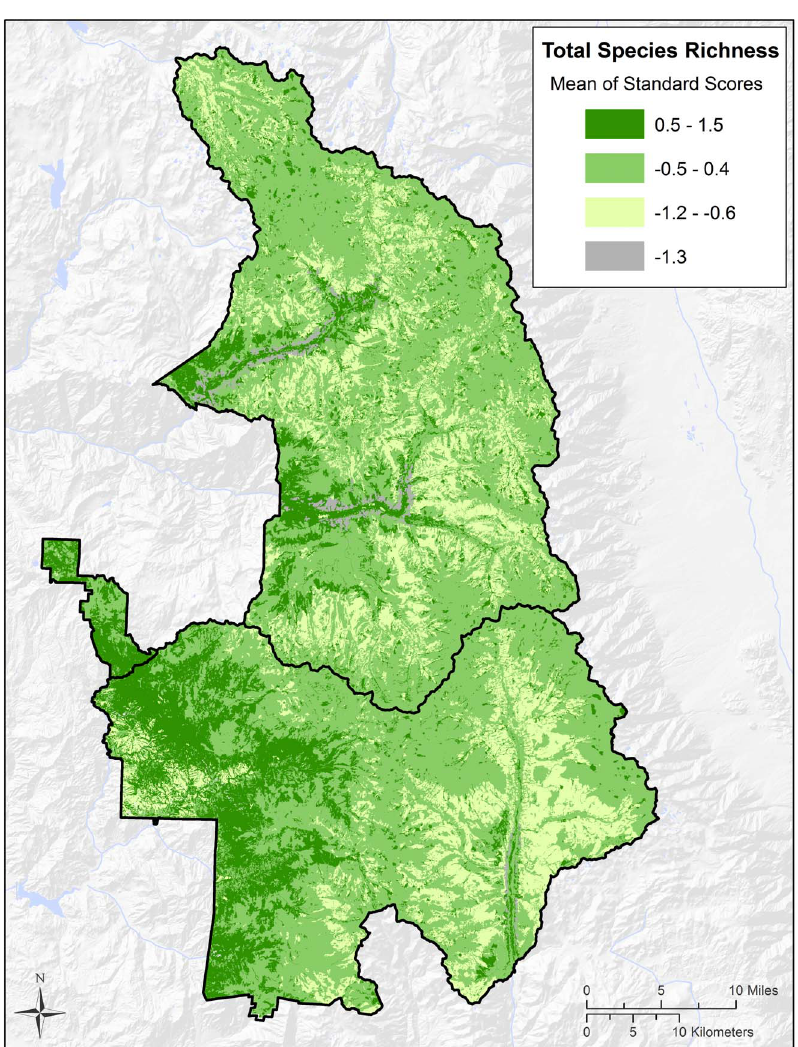
Figure 3. The distribution of total species richness by habitat type within Sequoia and Kings Canyon National Parks. Total species richness values (indices) represent the average of standardized species richness values for all four taxonomic groups combined: birds, mammals, herpetofauna and